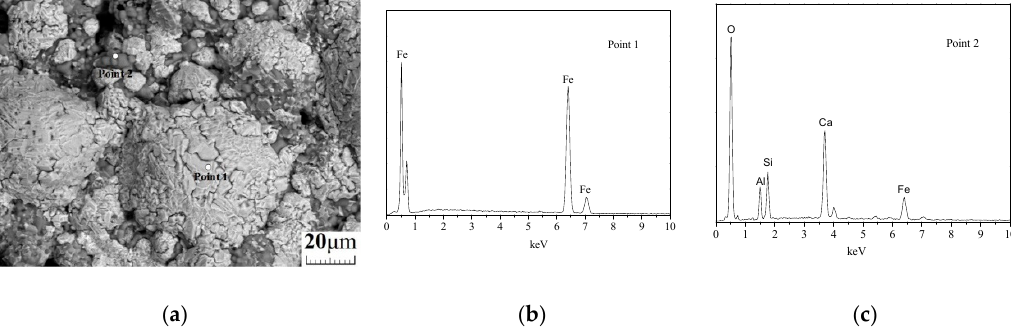
Figure 7. SEM–EDS results for sample C. ( a ) surface topography, ( b ) elementary composition of point 1, ( c ) elementary composition of point 2.